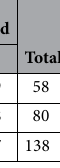
Table 6. Consistency analysis of fresh sample groups between Crispr and direct sequencing method in IDH1- R132H